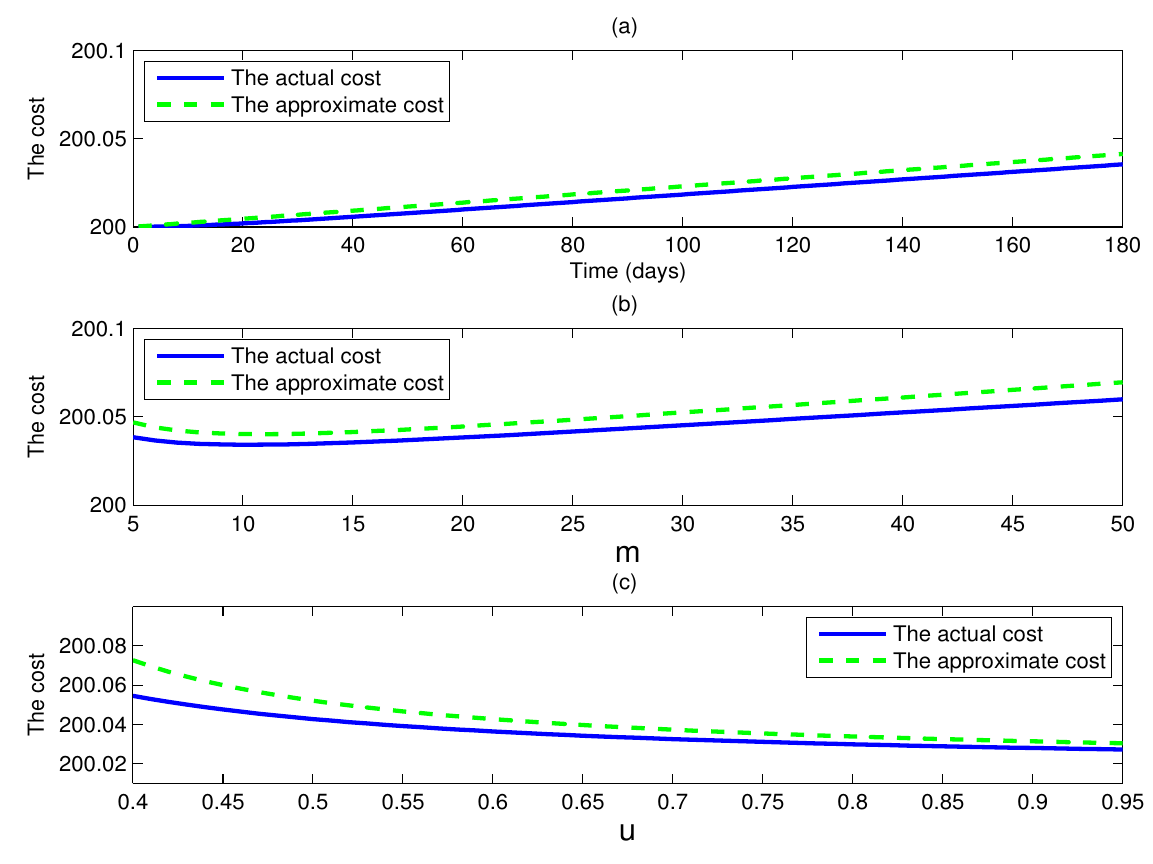
Figure 5. ( a ) Plots of the actual intervention cost and the approximate intervention cost as functions of time t , where R = 0 . 8 , and the cost coefficients c c and c = 100 ; ( b ) plots of the actual intervention cost and the approximate intervention cost 4 as functions of doses m , where R = 0 . 8 and the parameters as (a); ( c ) plots of the actual c intervention cost and the approximate intervention cost as functions of u , where m = 15 and the parameters as